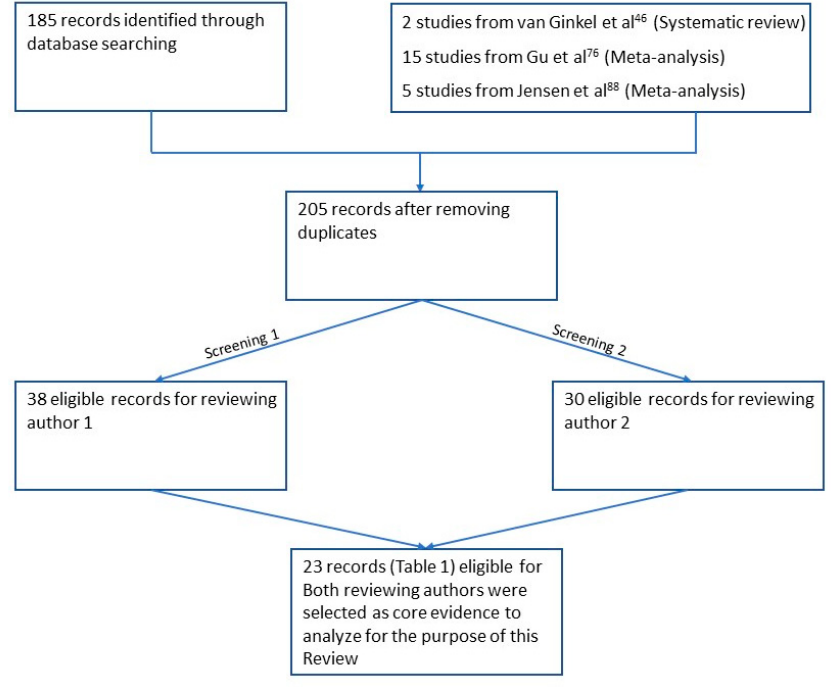
Figure 1. The flow diagram describes the strategy employed for literature research and screening. 3. Unmet Needs in HPV ‐ Related CEC and OPC for Early Detection, Prognosis, Treat